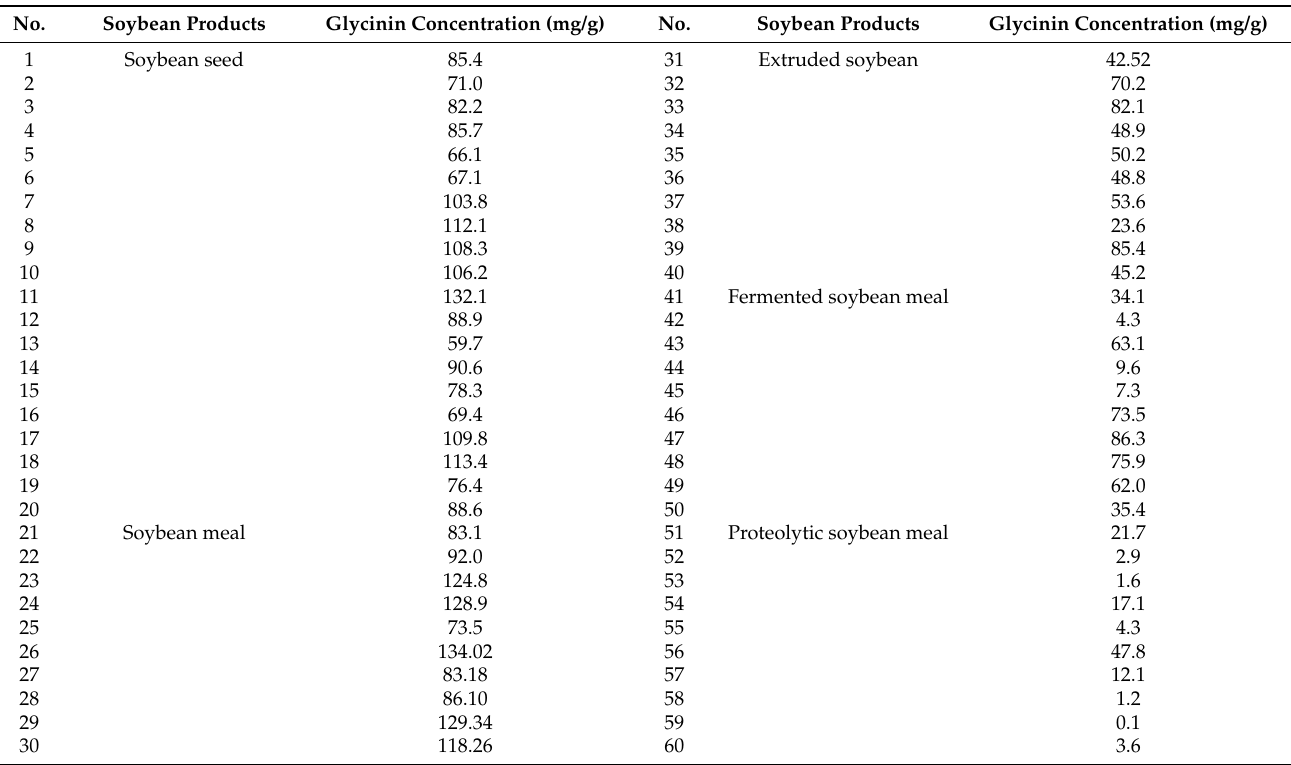
Table 5. Concentrations of glycinin in soybean samples with different